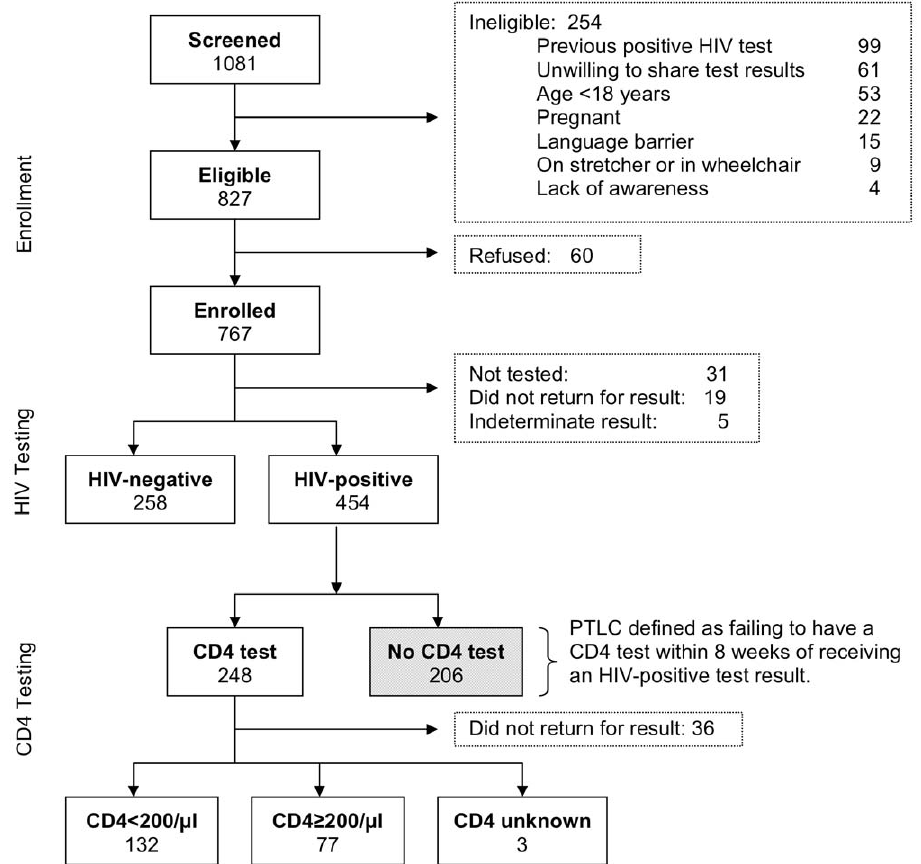
Figure 1. Study enrollment, HIV testing and CD4 testing flow chart. PTLC: Pre-treatment loss to care.